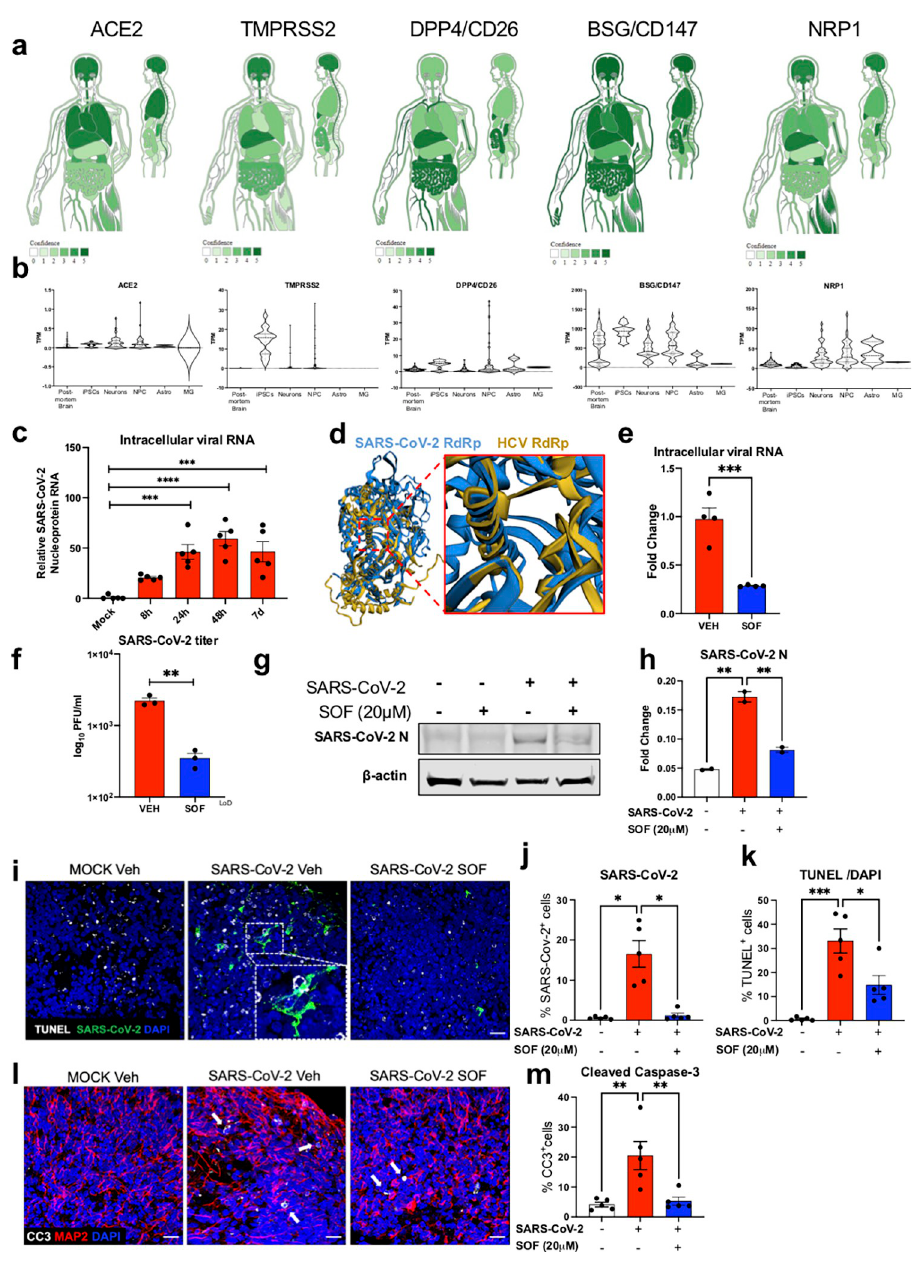
Fig 1. SARS-CoV-2 replicates in BCO and is inhibited by SOF treatment. a . Gene-tissue association based on transcriptomics and proteomics repositories generated using the Oxford database 45 . The scoring shows confidence of identification for the genes and proteins ACE2, DDP4/CD26, BSG/ CD147, TMPRSS2 and NRP1 in different human body tissues/organs both in coronal and sagittal planes; the darker the green tone is, the higher is the confidence score. b . Violin plots showing the frequency of distribution of normalized mRNA expression in adult postmortem brain (n = 172), induced pluripotent stem cells (iPSC, n = 18), neurons (n = 59), neural progenitor cells (NPC, n = 72), astrocytes (Astro, n = 3), and microglia (MG, n = 2) obtained from public databases 45–47 . All data points are represented as individual points inside each violin plot. c. Quantification of SARS-CoV-2 intracellular mRNA by qPCR of BCO infected at MOI 2.5. RNA was collected at 8, 24, 48 hours and 7 days. Bars represent mean. Error bars represent standard error mean (SEM) ��� p < 0.001, ���� p < 0.0001, n = 5 biological replicates (two pooled organoids per replicate, measured in triplicates), significance was assessed using one-way analysis of variance (ANOVA) with Dunnett’s post-hoc test. d. Structural superposition of SARS-CoV-2 RdRp (colored blue) and HCV RdRp (colored yellow) showing structural overlap within the polymerase active site. Both structures are statistically similar (p = 8.51e- 07) calculated from raw FATCAT score 73 . A total of 389 equivalent positions with a root-mean-square